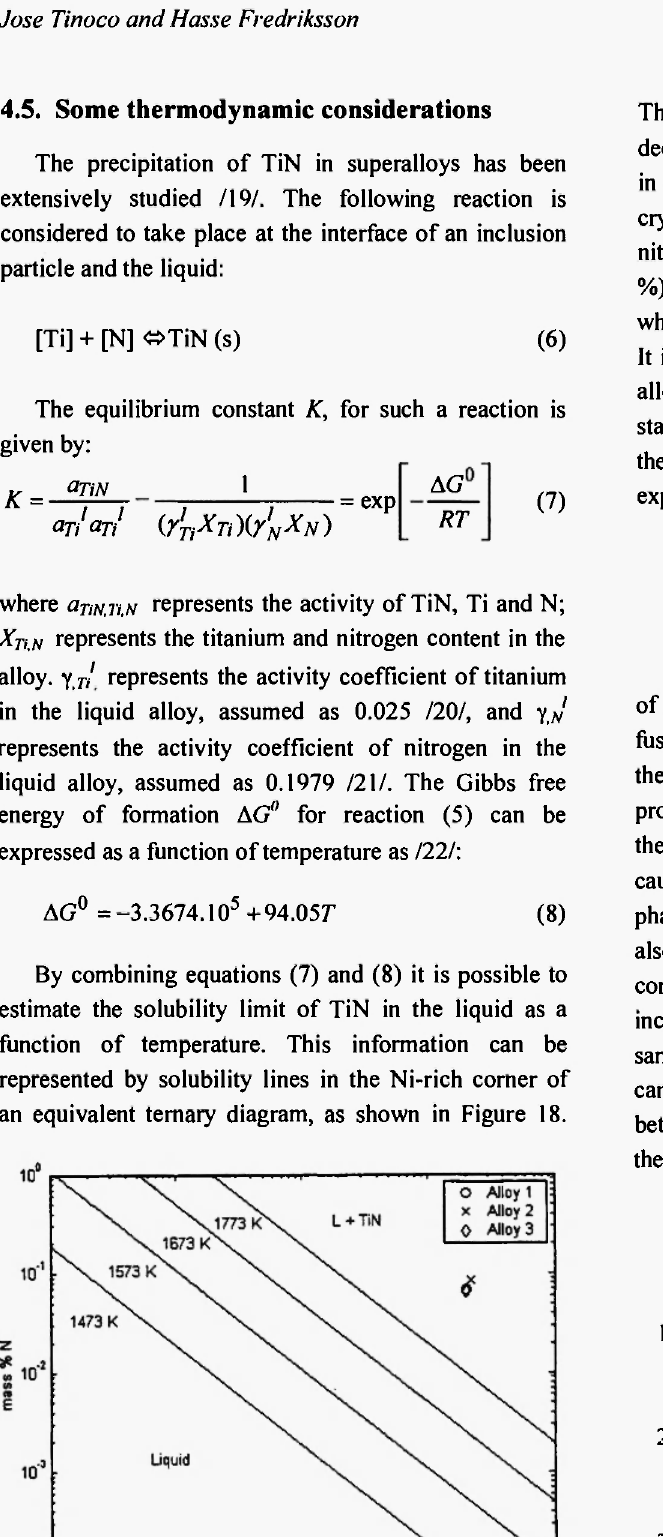
Fig. 18: Solubility line for TiN in liquid Inconel 625 as function of